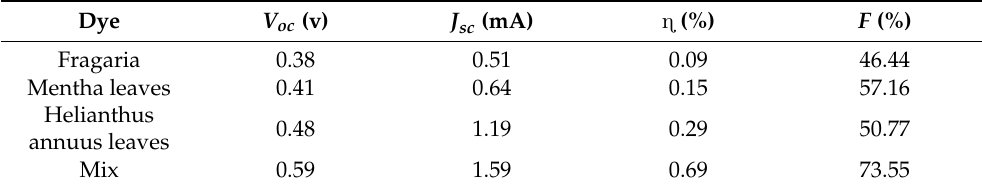
Figure 14. P – V curves for DSSCs for the four types of dyes adopted in this study. Figure 14. P–V curves for DSSCs for the four types of dyes adopted in this study. Table 1. Performance of Table 1. Performance of DSSCs.